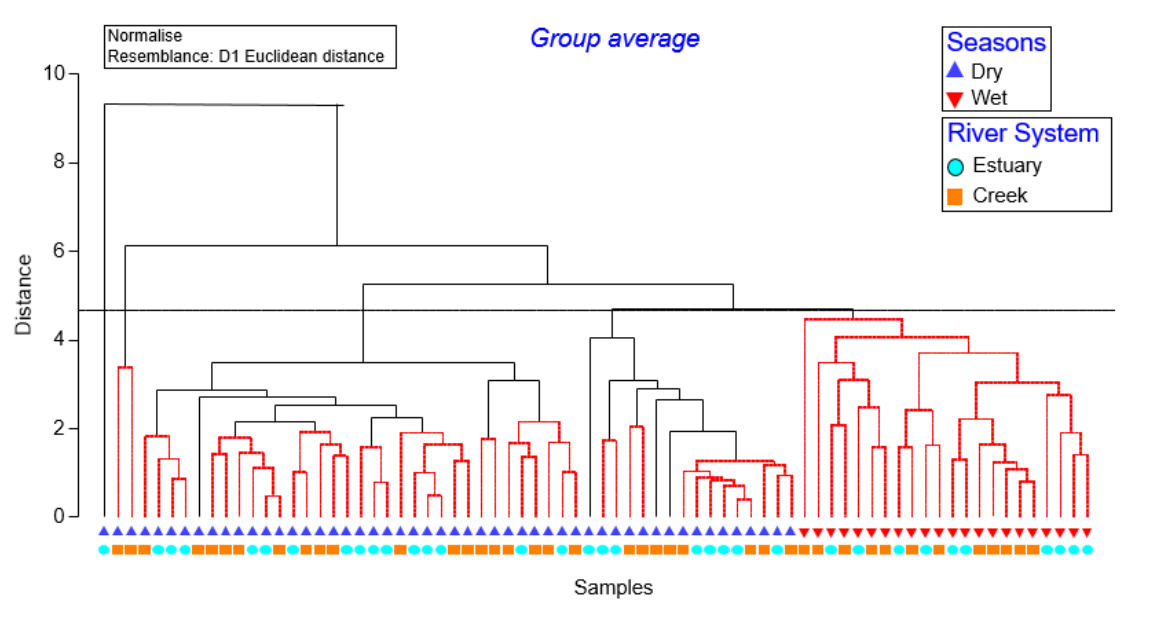
Figure 8. Hierarchical clustering of dendrogram showing dominant parameter in various clusters associated with seasons (Dry vs. Wet) and ecosystem (Creek vs. Estuary).